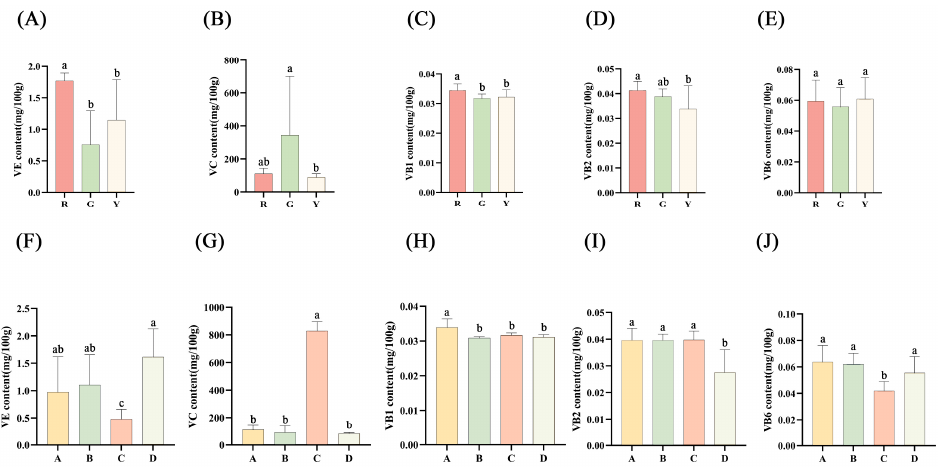
Figure 4. The contents of VE, VC, VB1, VB2 and VB6. ‘G’—green-fleshed kiwifruit. ‘R’—red-fleshed kiwifruit. ( A ) The contents of VE in different flesh color. ( B ) The contents of VC in different flesh color. ( C ) The contents of VB1 in different flesh color. ( D ) The contents of VB2 in different flesh color. ( E ) The contents of VB6 in different flesh color. ( F ) The contents of VE in species. ( G ) The contents of VC in species. ( H ) The contents of VB1 in species. ( I ) The contents of VB2 in species. ( J ) The contents of VB6 in species. ‘Y’—yellow-fleshed kiwifruit. ‘A’— A. chinensis . ‘B’— A. chinensis var. deliciosa . ‘C’— A. eriantha . ‘D’— A. eriantha × A. chinensis . Values are means ± SD of three individual biological reproductions. Different lowercase letters indicated statistically significant differences (Duncan’s multiple range test, p < 0.05) among different kiwifruit cultivars.